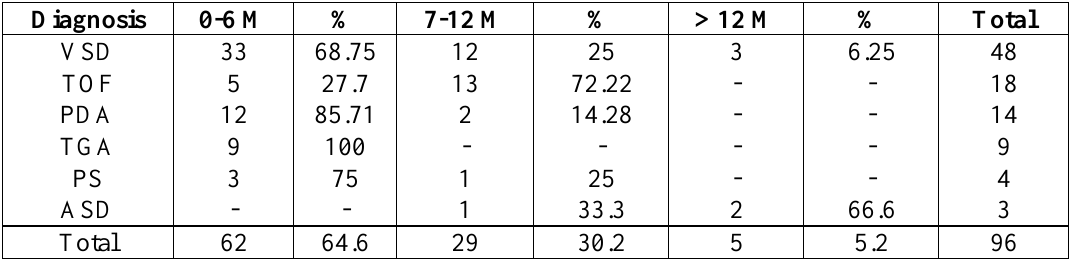
Table 4: Age distribution at diagnosis in different types of